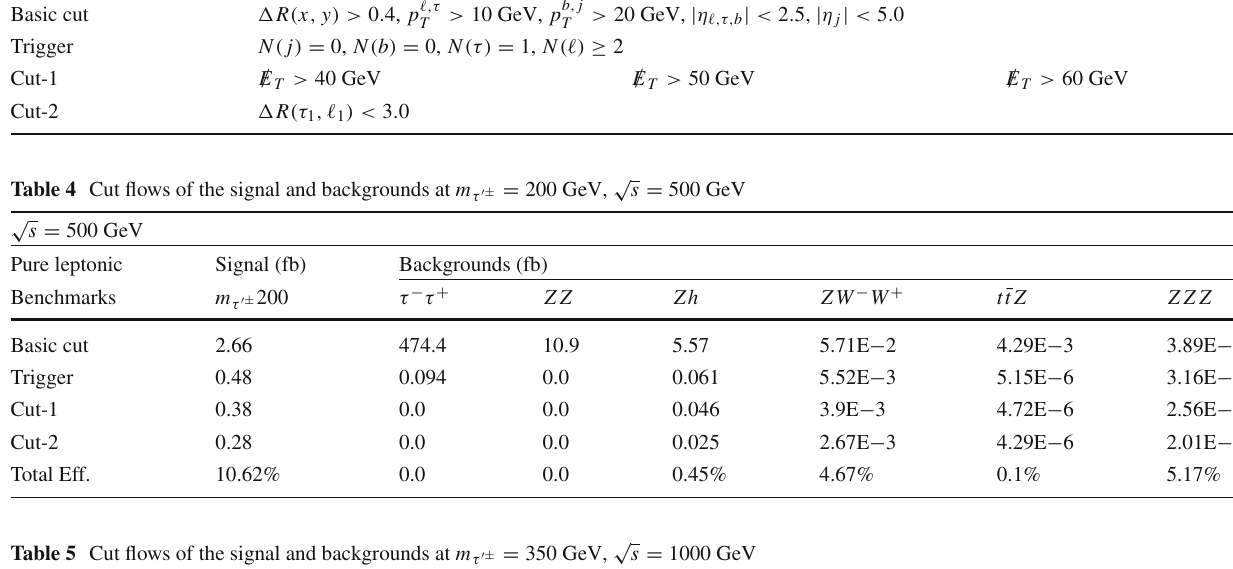
Table 5 Cut flows of the signal and backgrounds at m τ (cid:2)± = 350 GeV, √ s = 1000 GeV Pure leptonic Signal (fb)